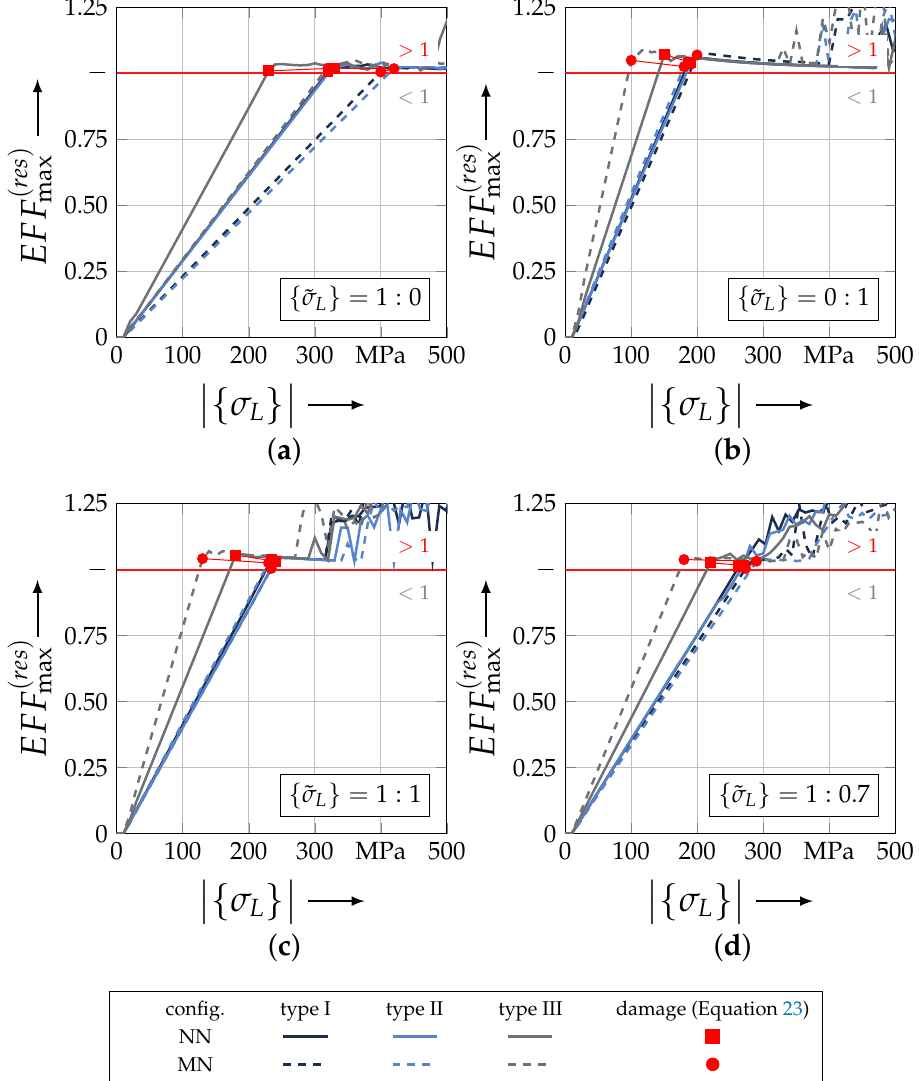
Figure 18. Results of the damage identification according to Equation (23) ( EFF (res) max ) of the considered rUCs at selected load paths { ˜ σ L } = ( a ) 1:0, ( b ) 0:1, ( c ) 1:1 and ( d )